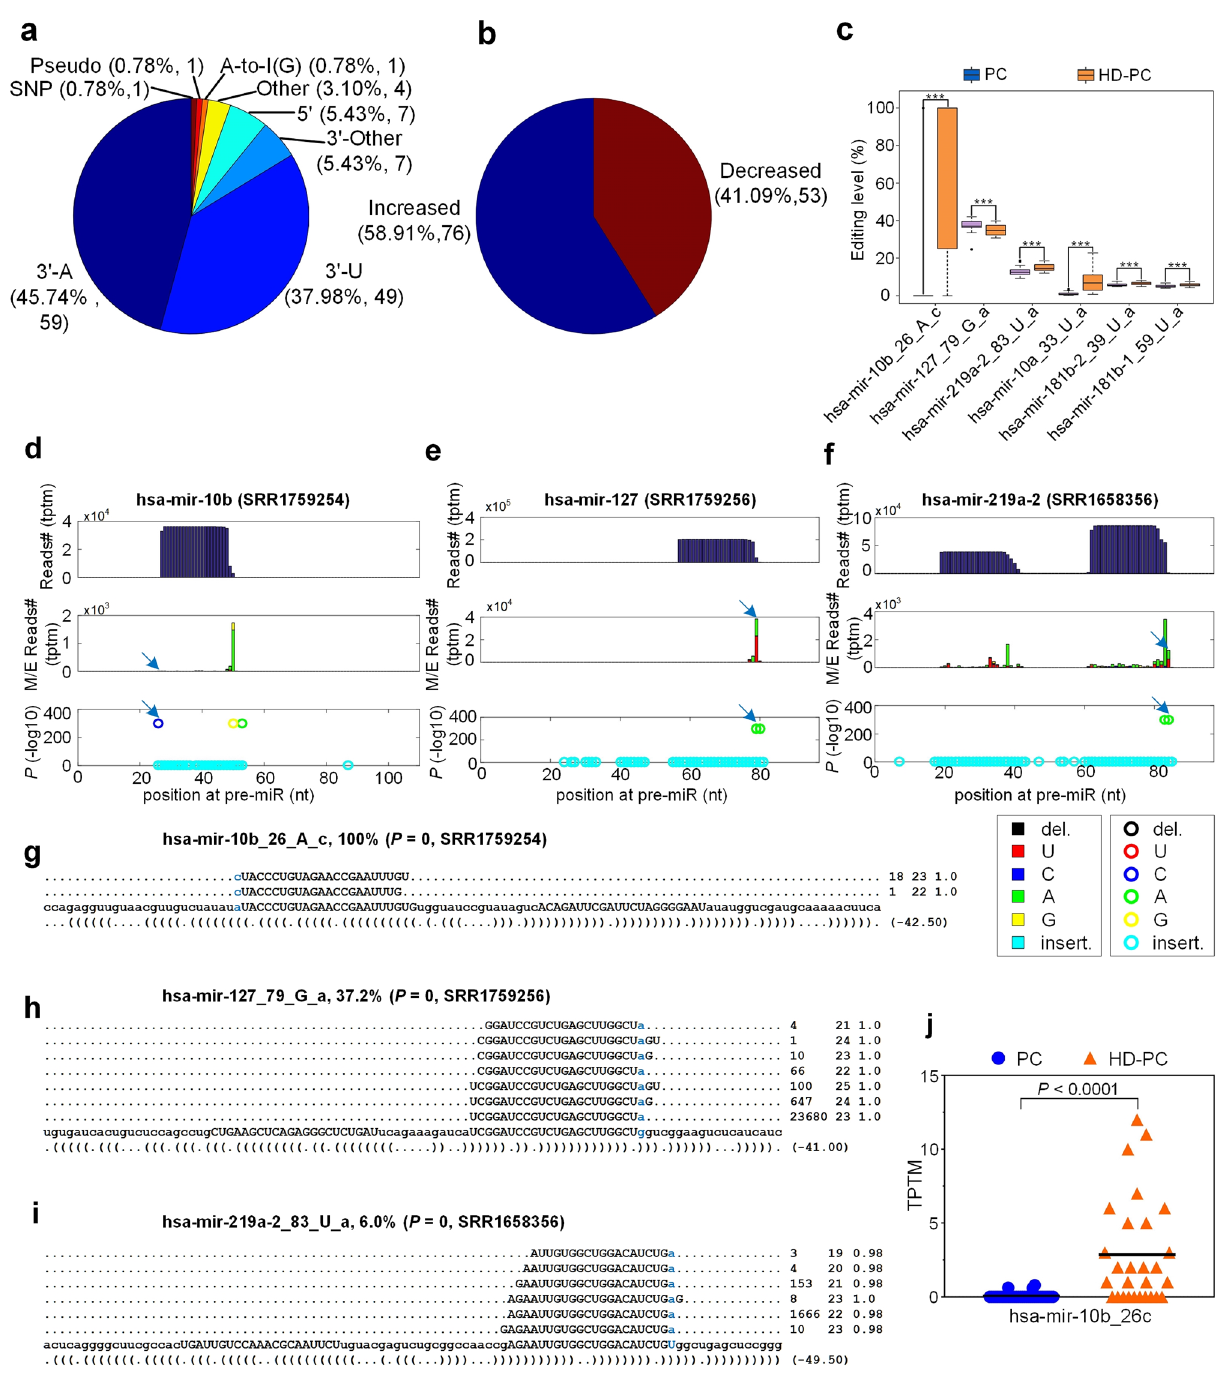
Figure 5. The 129 miRNA M/E sites that have significantly different editing levels in HD-PC samples when compared to healthy controls. ( a ) The categories of the 129 M/E sites. ( b ) The change of editing levels of 129 M/E sites in HD-PC samples compared to PC samples. ( c ) Then editing levels of six miRNA M/E sites that have significantly different editing levels in HD-PC samples when compared to PC samples. “***” indicate P -values smaller than 0.05, Mann-Whitney U -tests and corrected with the Benjamini and Hochberg method 85 . ( d ) The MiRME map of hsa-mir-10b in one of the HD-PC samples (SRR1759254). ( e ) The MiRME map of hsa-mir-127 in one of the HD-PC samples (SRR1759256). ( f ) The MiRME map of hsa-mir-219a-2 in one of the Unknown samples (SRR1658356). ( g-i ) The details of hsa-mir-10b_26_A_c in SSR1759254, hsa-mir-127_79_G_a in SSR1759256 and hsa-mir-219a-2_83_U_a in SSR1658356, respectively. The edited nucleotide are shown in blue. And the first number on the right indicates the number of raw sequencing reads, the second number indicates the length of the reads, and the third number indicates the weight of the reads on this locus as calculated by the cross-mapping correction algorithm 84 . ( j ) Comparisons of normalized expression levels (in TPTM) of hsa-mir- 10b_26c, i.e., hsa-mir-10b-5p with additional cytosine at 5’ end, in the HD-PC and PC